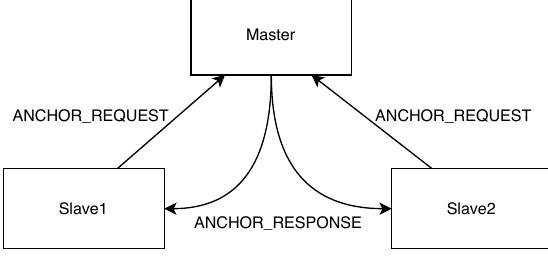
Figure 3. Anchor request message